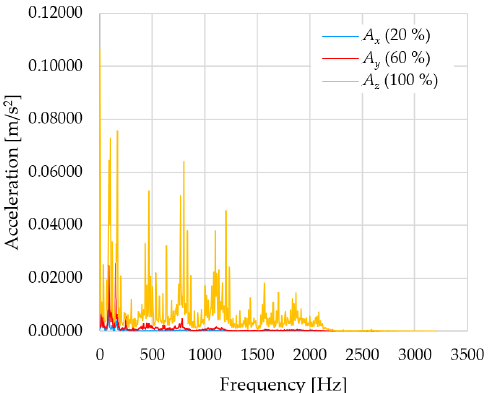
Figure 13. Acceleration waveforms depending on frequency in Y -axis for velocity 20, 60 and 100%.